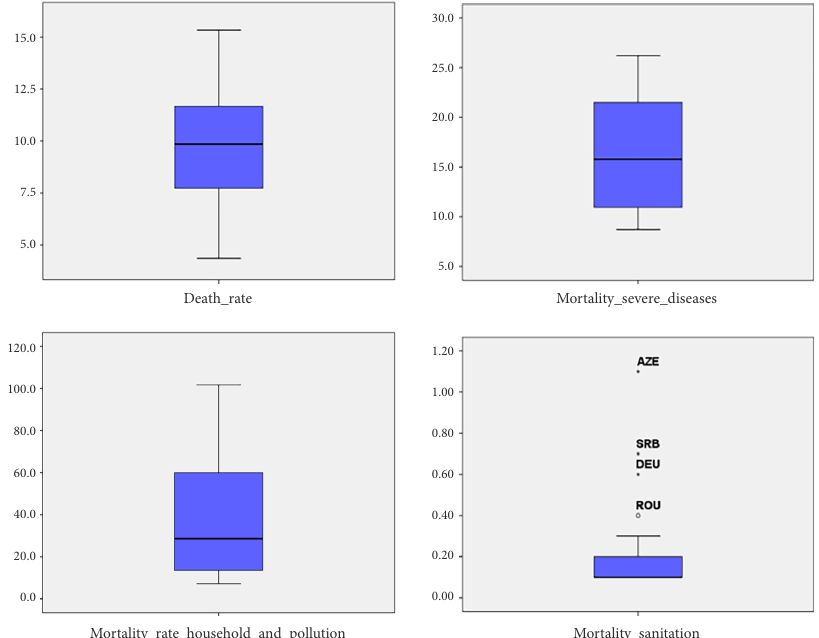
Figure 2. Box-plots for mortality indicators (source: authors’ computation using IBM SPSS Statistics 21)